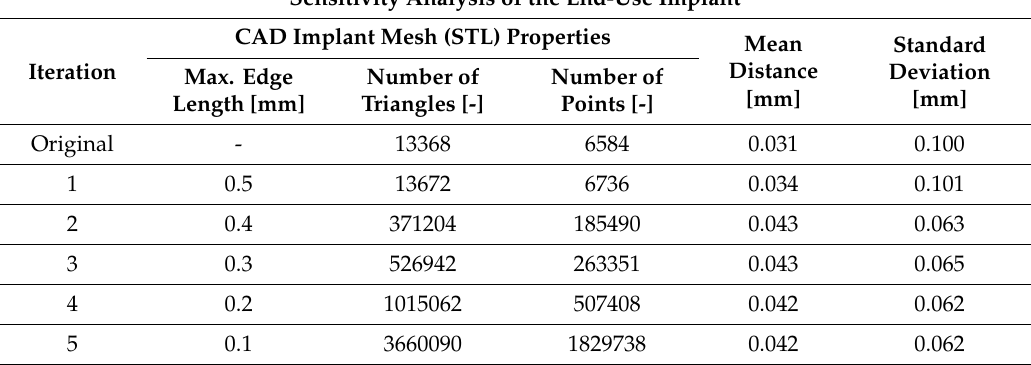
Figure 8. The additive manufacturing error of the end-use implant on the nominal CAD implant with the verified mesh size.